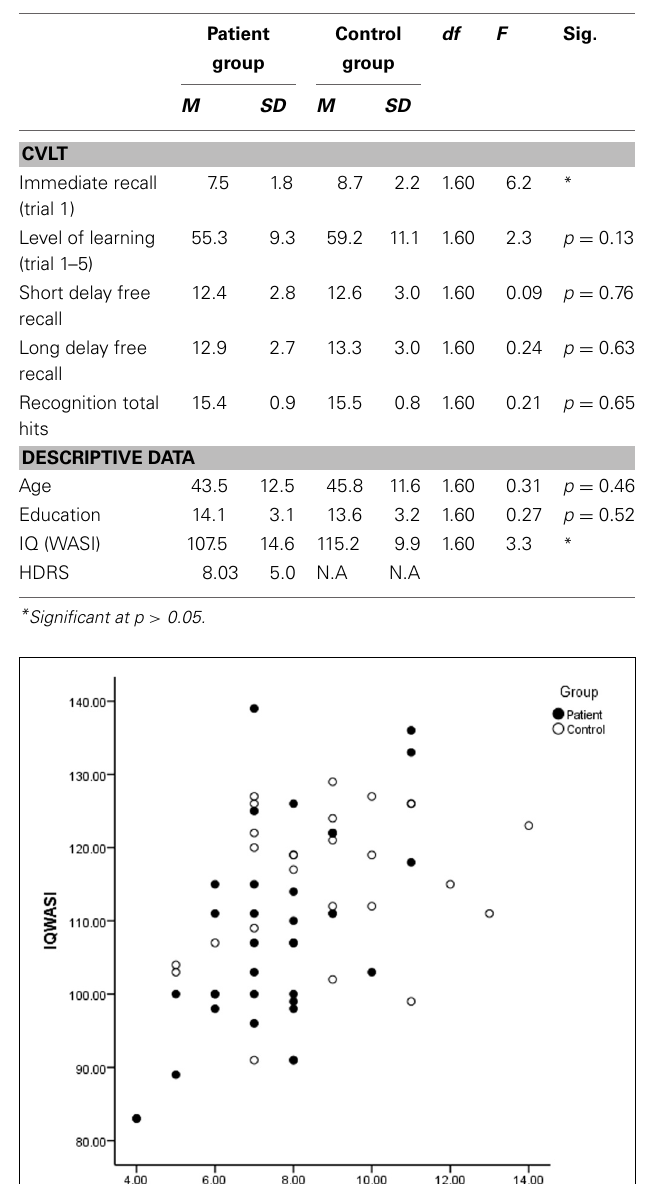
Table 2 | Test performance and descriptive data for both groups.